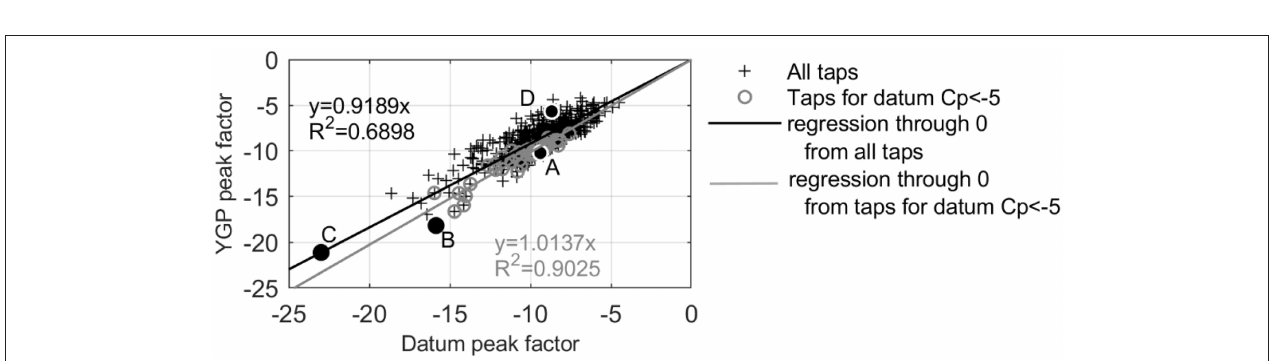
FIGURE 13 | Kurtosis vs. Anomaly: (A) EVA N = 16 and T = 10min ( N peak = 11), (B) XIMIS T = 160min ( N peak = 11), (C) XIMIS T = 60min ( N peak = 30), (D) YGP T = 60min ( N peak = 30).